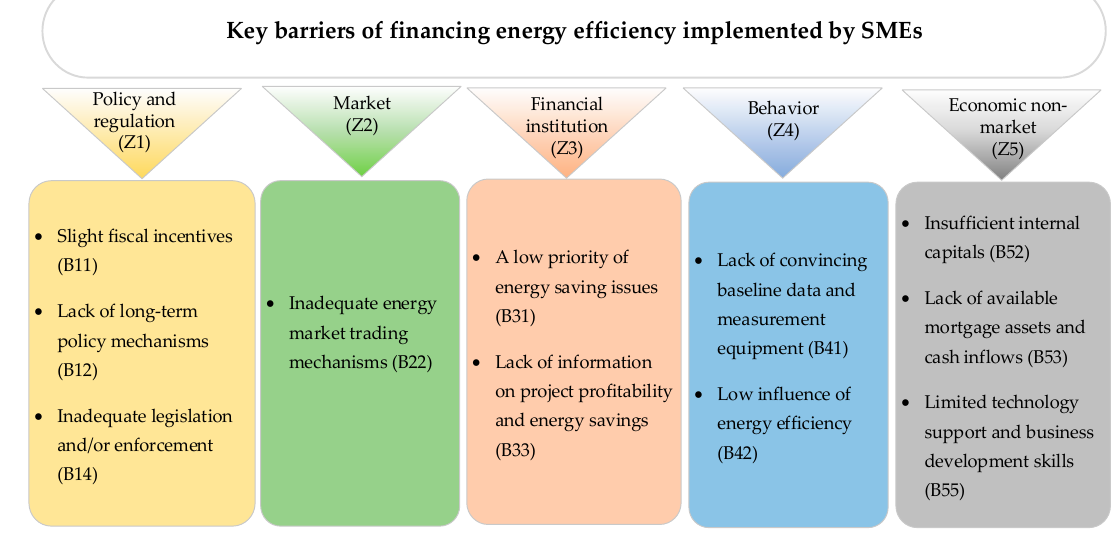
Table 14. Ranks and attributes of the key financial barriers.